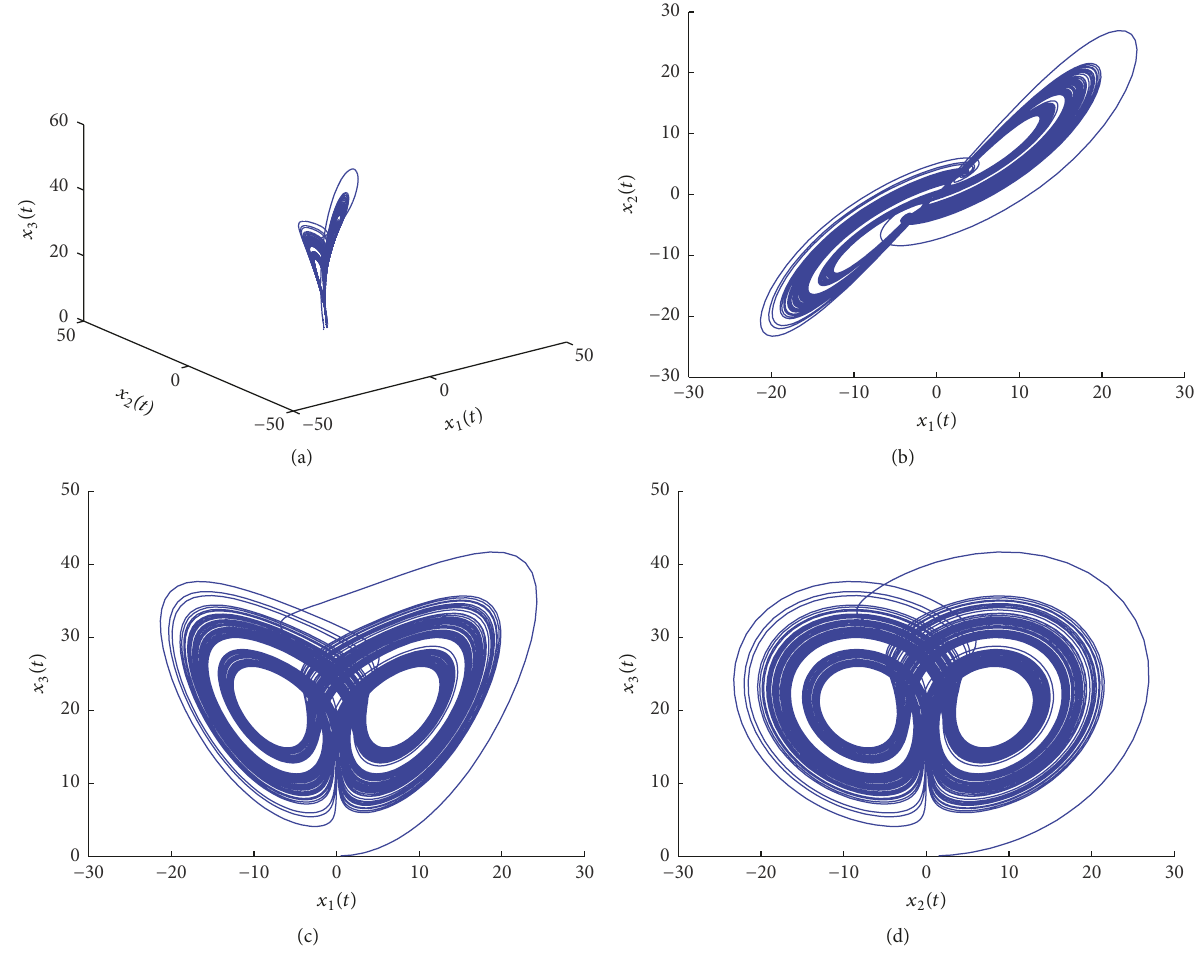
Figure 4: 3D and 2D chaotic attractors of fractional system